Question: Which kind of chart has been used to present this data?
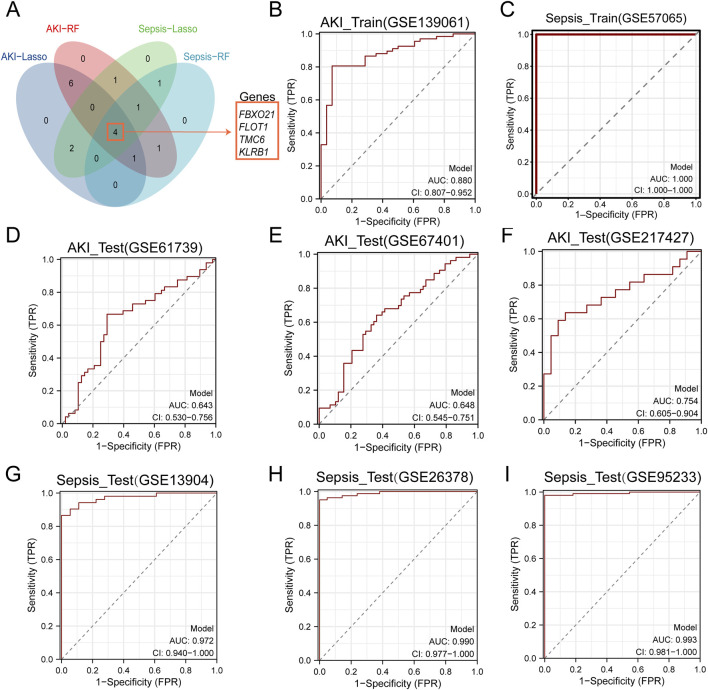
Answer: line